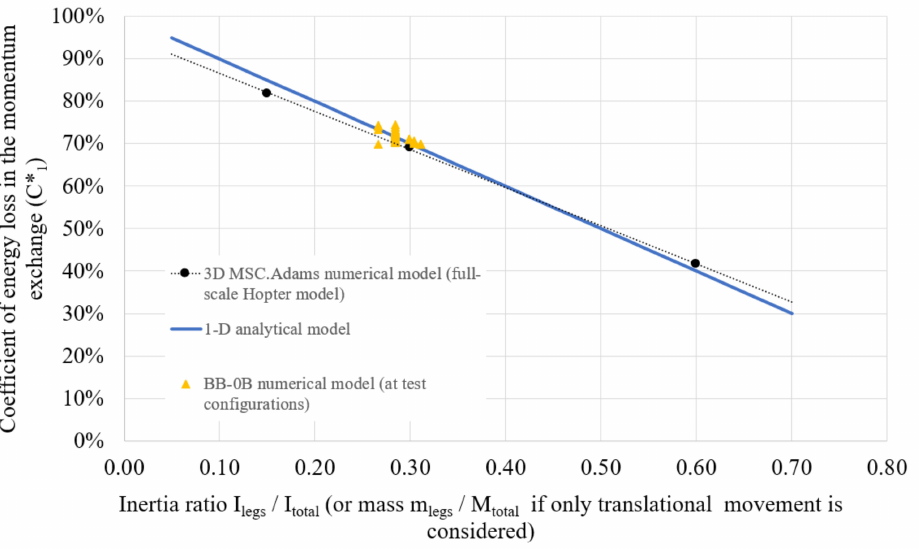
Figure 9. Jumping efficiency factor ( C ∗ Hopter ( M total